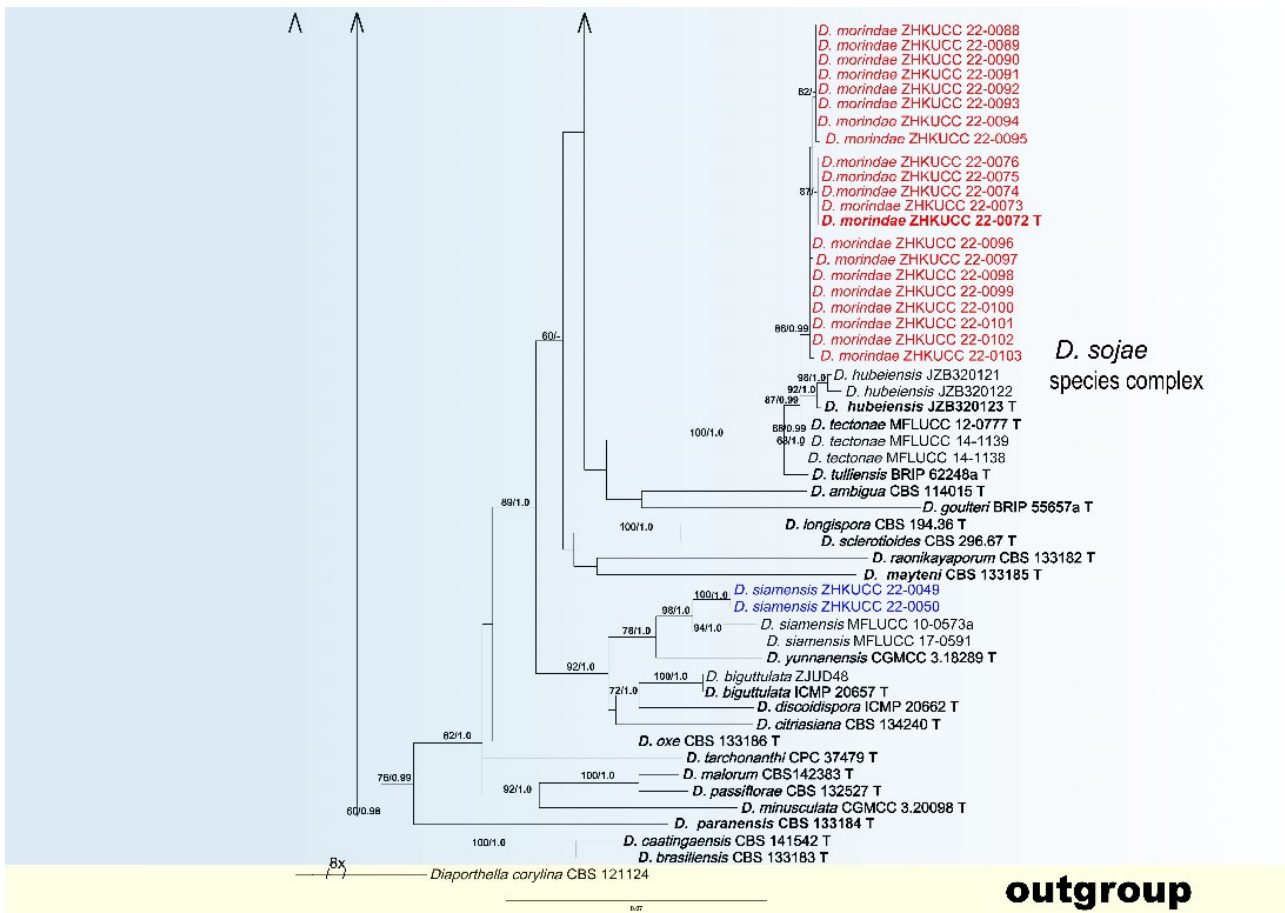
Figure 2. The best scoring RAxML tree obtained using the combined dataset of ITS, tef1-α , cal , his , and β-tubulin sequences. Diaporthella corylina (CBS 121124) was used to root the tree. Bootstrap support values equal to or greater than 60% in ML and BYPP equal to or greater than 0.95 are shown as ML/BYPP above the respective node. The isolates belonging to the current study are given in blue for known species, and novel taxa are shown in red. Ex-type strains are bold, with T at the end of the strains numbers. The expected number of nucleotide substitutions per site is represented by the scale bar.